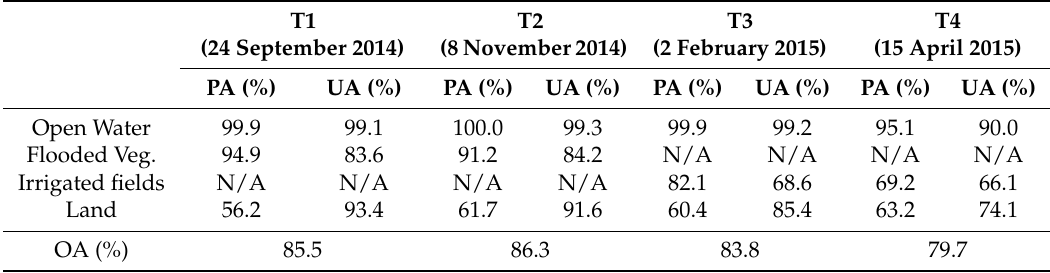
Accuracy assessment of the monotemporal classification t1 (24 September 2014), t2 (8 November 2014), t3 (2 February 2015), t4 (15 April 2015), with Producer’s Accuracy (PA) and User’s Accuracy (UA) for each class, Overall Accuracy (OA) for each image, non-existing classes are marked as